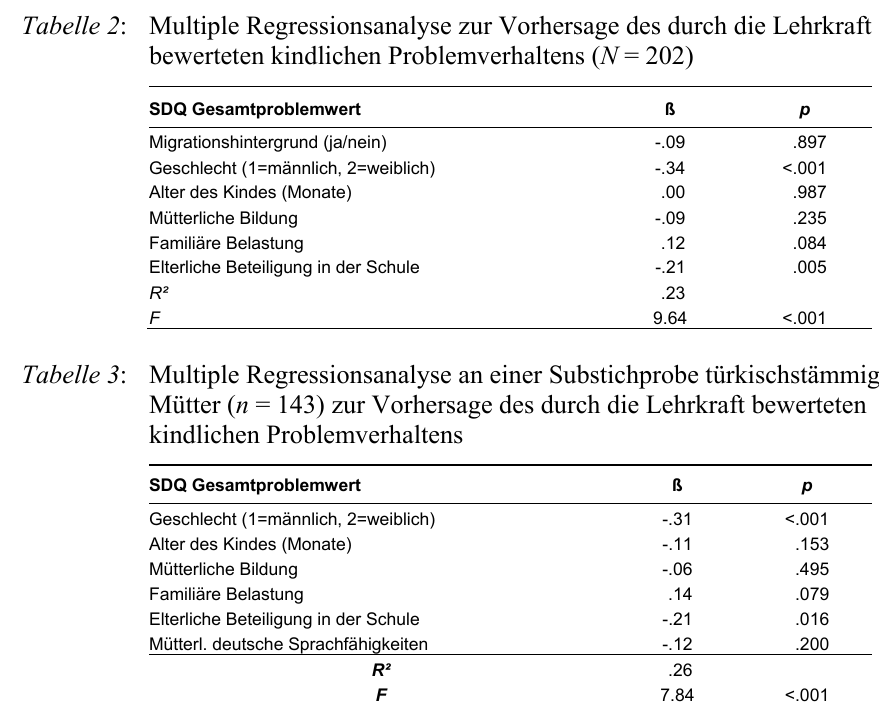
Tabelle 2 : Multiple Regressionsanalyse zur Vorhersage des durch die